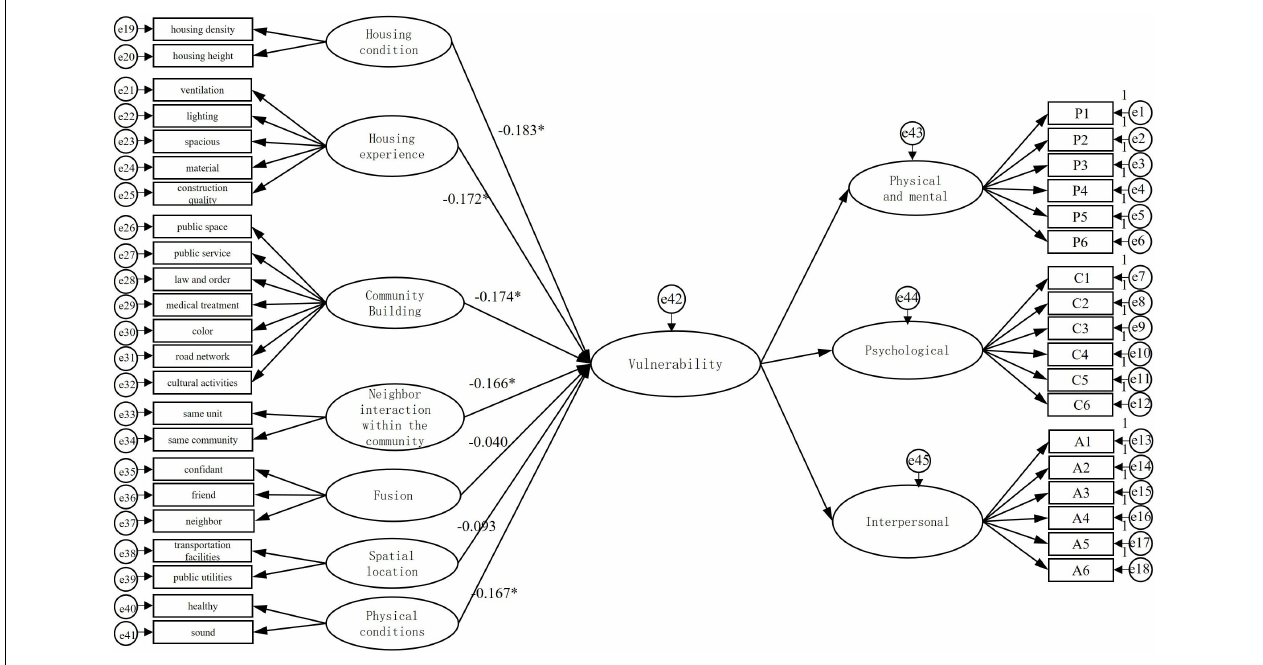
FIGURE 6 | Structural results of mental vulnerability